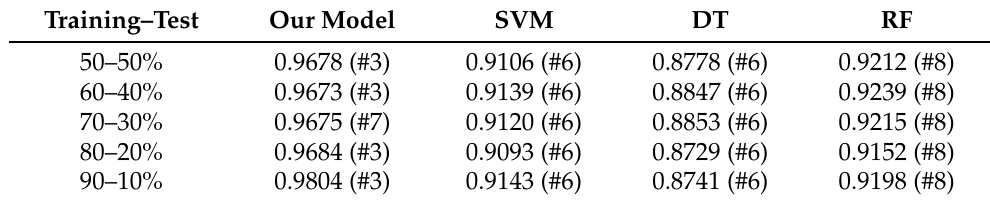
Table 9. First experiment set: best performance comparison for different methods by Accuracy.